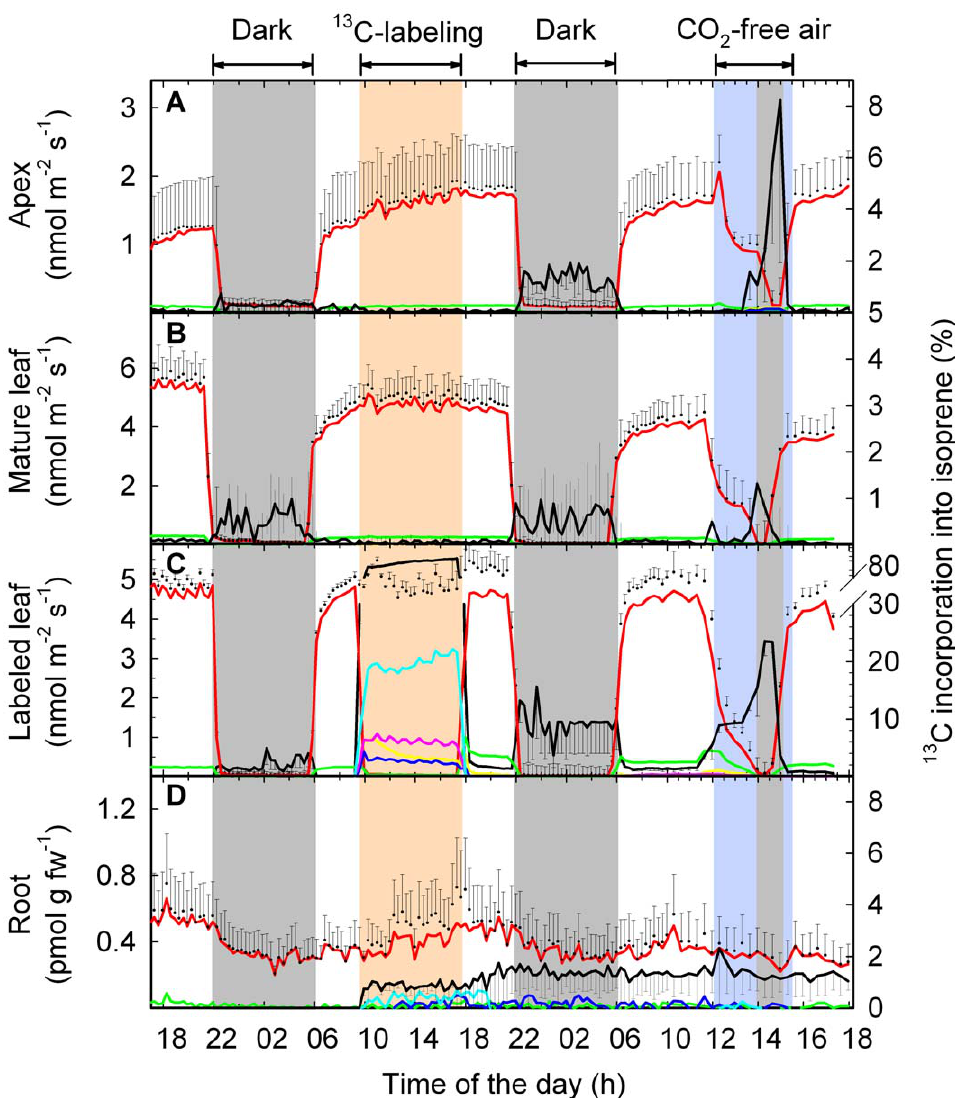
Figure 6. Isoprene emission of intact poplar plants and incorporation of label of upon 13 CO 2 feeding. Total isoprene emission (black symbols), its 13 C incorporation (black line) and isotopic composition (m74, light blue; m73, magenta; m72, dark blue; m71, yellow; m70, green; m69, red) from (A) the apex, (B) a fully expanded leaf, (C) 13 CO 2 -labeled mature leaf, (D) and the root system of intact plants. The labeling period is shown in orange, stress (absence of CO 2 ) is indicated by a blue background, and dark conditions are marked in grey. Details of the experimental phases can be found in the Materials and Methods section. Data represent the mean of 3 experiments 6 s.e. (omitted for isotopic composition).